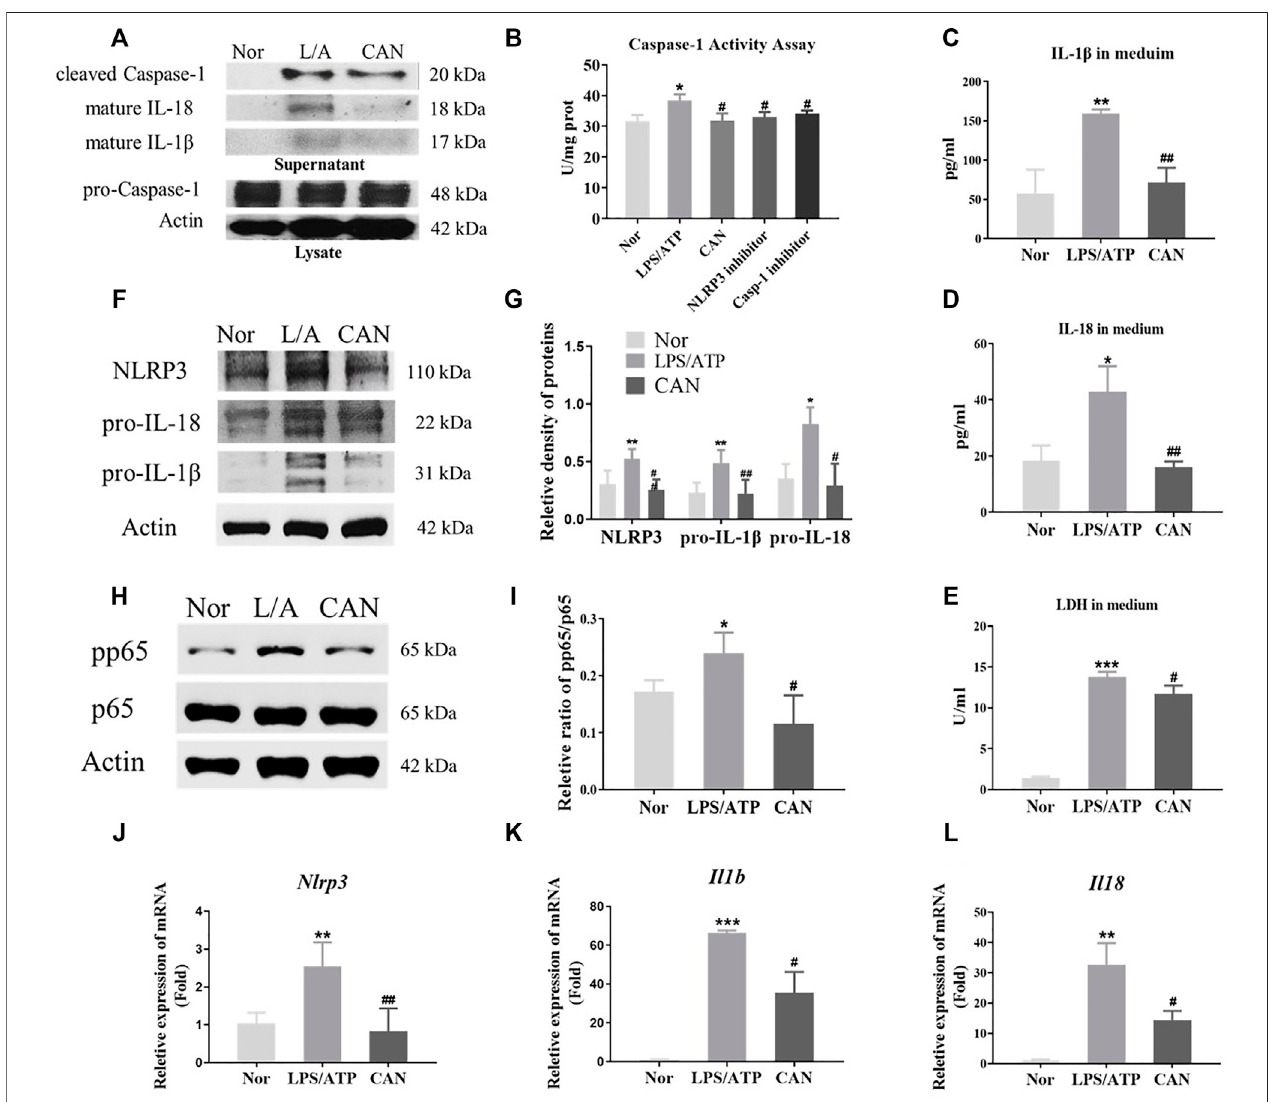
FIGURE2| Canagli fl ozininhibitsNLRP3in fl ammasomeactivationinLPS/ATP-treatedJ774A.1cells.J774A.1cellswereprimedwithLPS(500 ng/ml)for6 hinthe presence or absence of CAN (10 μ M), then stimulated with 5 mM ATP for 30 min. (A) Western blotting analysis of supernatant and whole cell lysate from J774A.1 cells. (B) Caspase-1activityassay.TheNLRP3inhibitorMCC950(10 μ M)andthecaspase-1inhibitorVRT-043198(1 μ M)wereusedaspositivecontrols. (C) IL-1 β and (D) IL- 18insupernatantweremeasuredbyELISA. (E) LDHreleaseinsupernatantwasassessed. (F,G) EffectsofCAN onthelevelsofNLRP3in fl ammasome-associated proteins in J774A.1 cells. (H,I) CAN inhibited phosphorylation of p65 in J774A.1 cells. (J – L) CAN down-regulated mRNA levels of NLRP3, IL-1 β and IL-18 in J774A.1 cells. Nor, normal control group; LPS/ATP (L/A), untreated LPS/ATP control group; CAN, CAN-treated LPS/ATP group. Data were expressed as mean ± SD ( n = 3). Differences with a probability value of < 0.05 were considered signi fi cant (* p < 0.05, ** p < 0.01, *** p < 0.001 vs. Nor; # p < 0.05, ## p < 0.01, ### p < 0.001 vs.